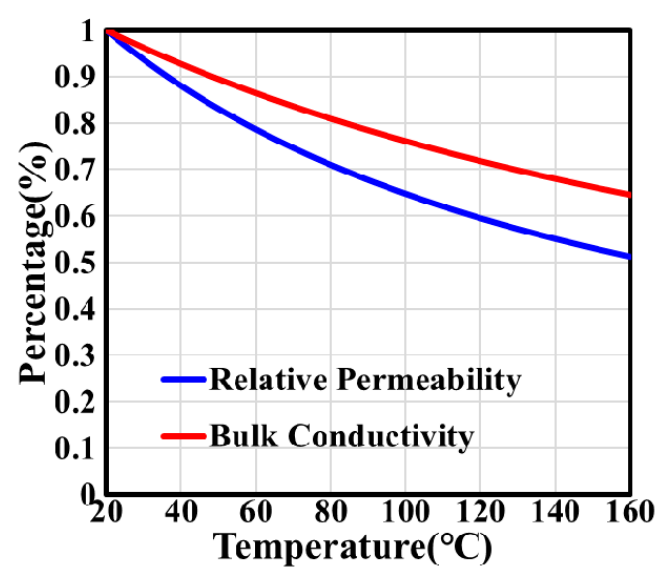
Figure 5. Winding relative permeability and bulk conductivity with temperature.